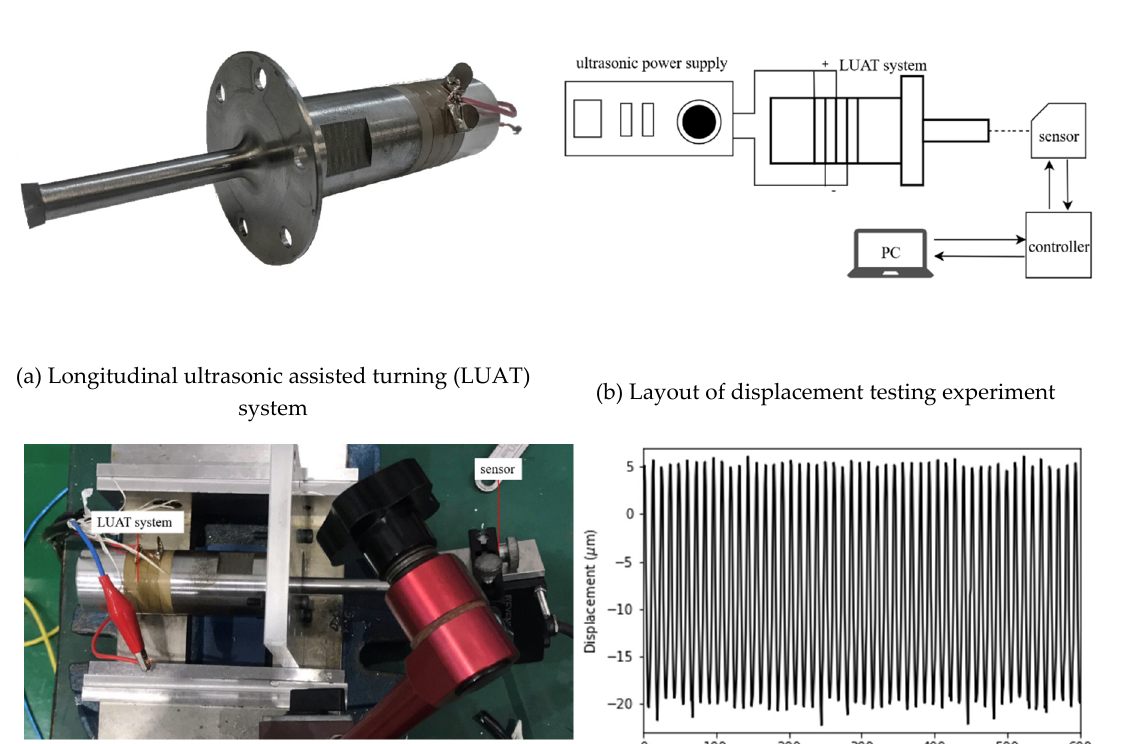
Table 3. Related parameters of linear D–P model of